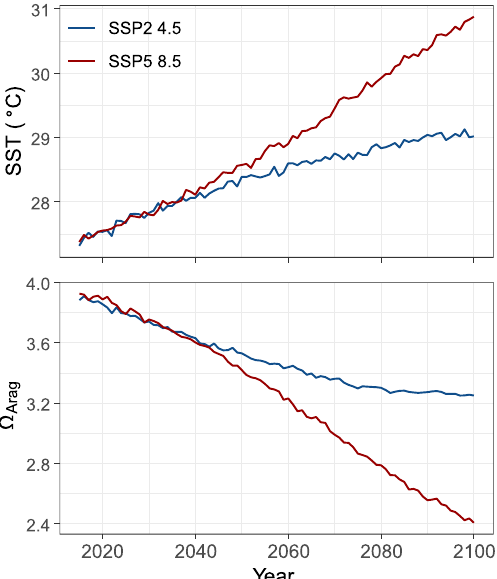
Figure 4. CMIP6 mean annual sea surface temperature (SST) and aragonite saturation state (Ω Ar ) projections from 2019 to 2100 under two different emission scenarios. In blue; SSP2-4.5 and in red;